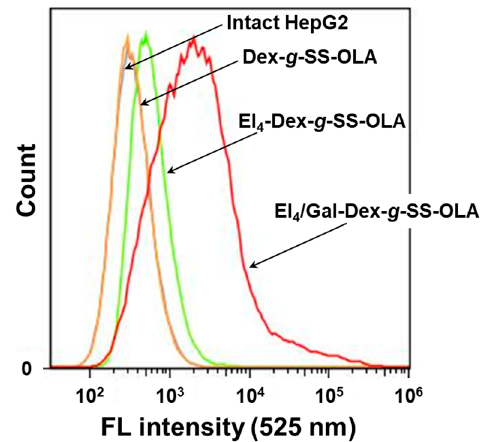
Figure 6. Results of flow cytometric analysis for HepG2 cells incubated with fluorescein isothiocyanate isomer I (FITC)-labeled nanogels for 4 h. Intact HepG2 cells (grey, almost overlapped with orange), Dex- g -SS-OLA (orange), EI 4 -Dex- g -SS-OLA (light green), EI 4 /Gal-Dex- g -SS-OLA nanogels (red). FL: fluorescence.